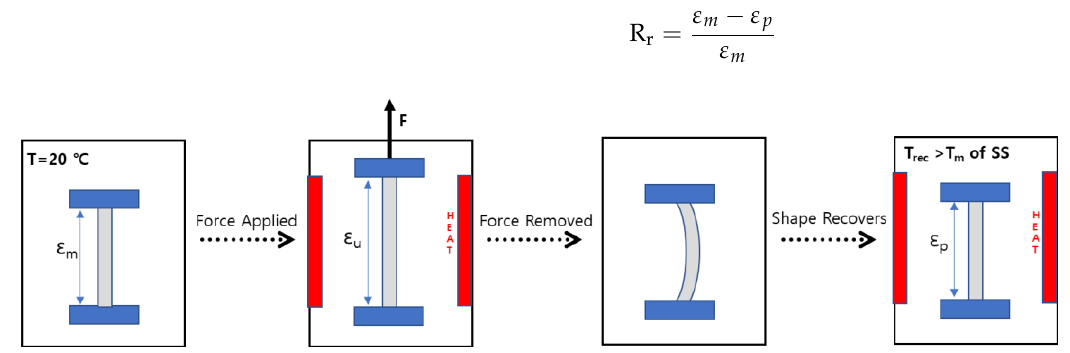
Figure 2. Schematic of the shape memory test carried out for the bio-based SMTPU films.